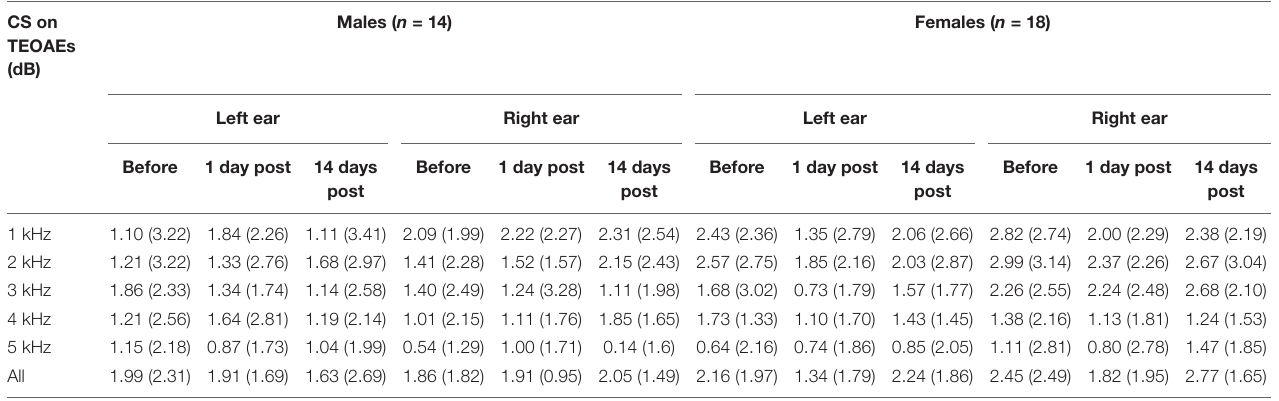
TABLE 2 | Effects of noise exposure on contralateral suppression (CS) on transient evoked otoacoustic emissions